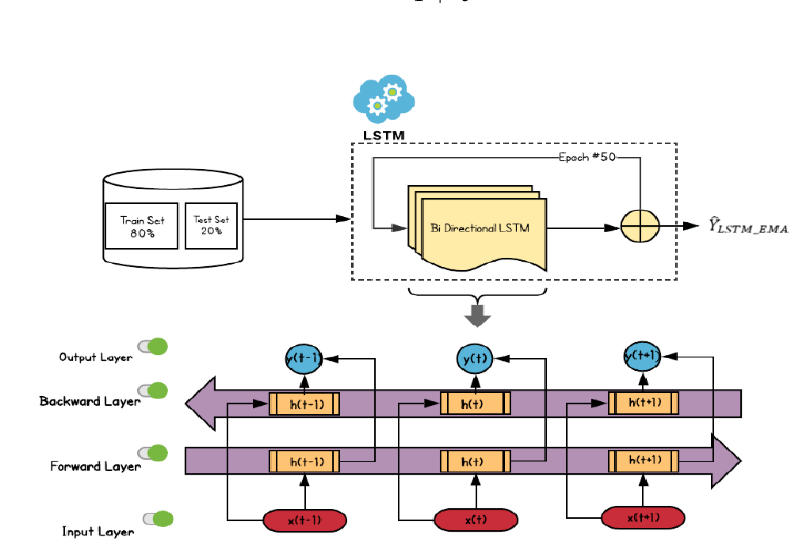
Figure 4. Configuration of bidirectional (BD) long short-term memory (LSTM) for the proposed framework .